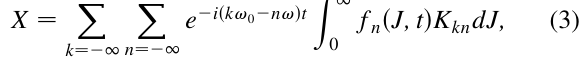
. Observations 22